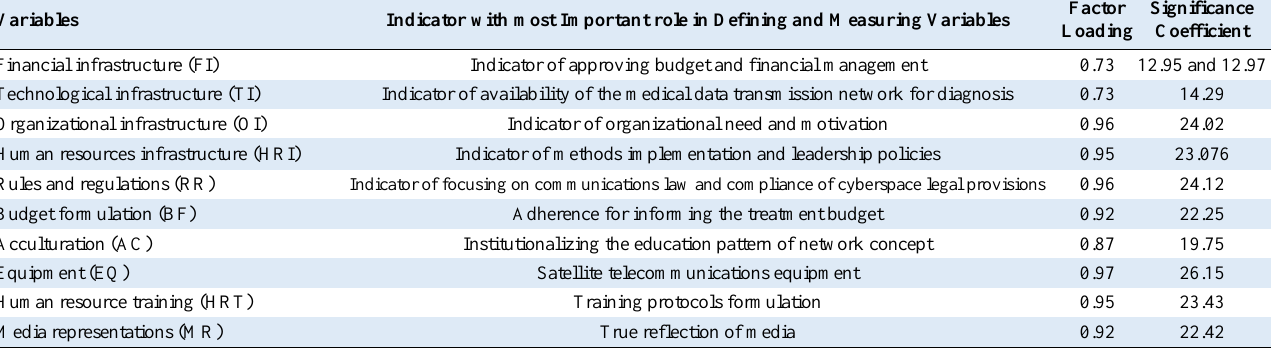
Table 4. Results of factor analyses of research